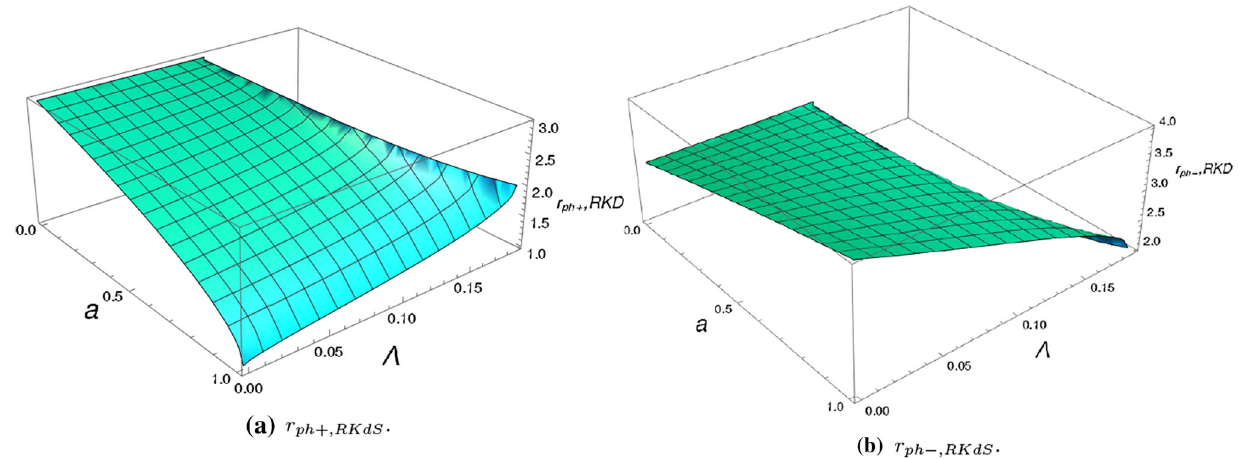
Fig. 3 Behaviour of radius of the equatorial circular photon orbit, r ph − , RKdS and r ph + , RKdS , for a ∈ [ 0 , 1 ] and (cid:2) ∈ [ 0 ,(cid:2) Max , RKdS ] . As the black hole spin increases, r ph + , RKdS decreases while r ph − , RKdS